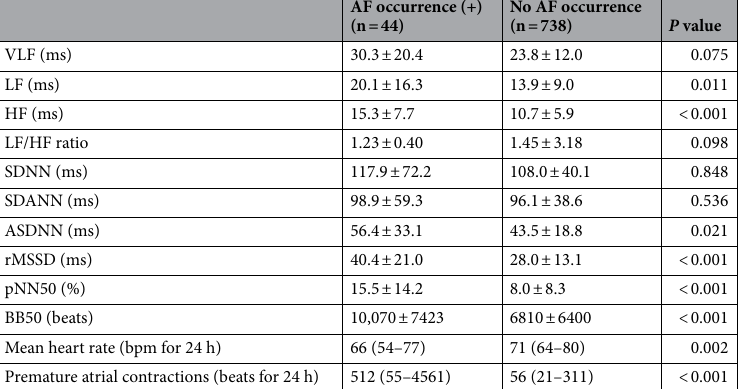
Table 3. Differences in heart rate variability and Holter data according to the occurrence of atrial fibrillation in patients with hypertension. VFL, very low frequency; LF, low frequency; HF, high frequency; SDNN, standard deviation of the NN interval; SDANN, standard deviation of all 5-min mean NN interval; ASDNN, average standard deviation of all 5-min RR intervals; rMSSD, square root of the mean squared differences of successive NN interval; pNN50, the percentage of RR intervals that are more than 50 ms different from the previous interval; BB50, the count of intervals that are more than 50 ms different from the previous interval.